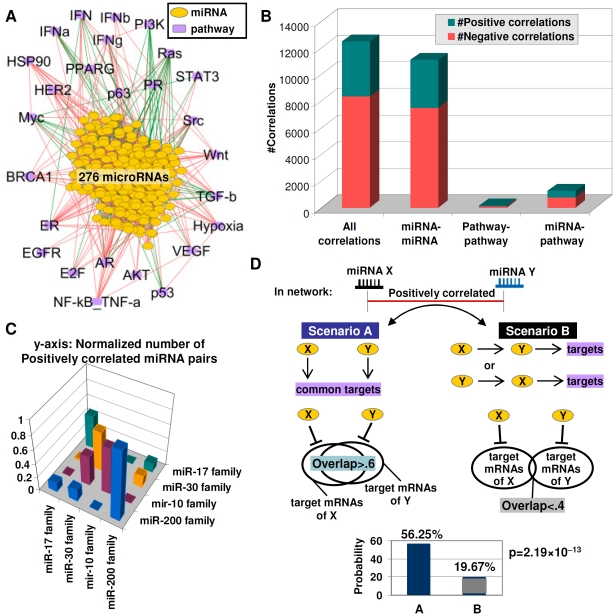
Functional redundancy in the miRNA–pathway network.A) The miRNA–pathway network. Lines represent significant correlations across 276 miRNAs and 26 pathways (red = positive, green = negative). Yellow nodes are miRNAs and purple nodes are pathways. B) Number of positive and negative correlations between different node types (miRNA-miRNA, pathway-pathway, miRNA–pathway). C) Frequency of positively correlated miRNA pairs within and between miRNA families. A taller column indicates a higher frequency of positive miRNA-miRNA correlations. miRNA pairs from the same family show a higher frequency of correlations compared to miRNA pairs between different families. D) Possible scenarios explaining positive correlations between two miRNAs. Scenario A (left) – miRNAs act independently but have common downstream effects (redundancy); Scenario B (right) – one miRNA directly regulates the second miRNA. (bottom) miRNAs with significant overlaps in target mRNAs (overlap ratio >0.6) are more likely to be positively correlated compared to miRNAs with small target mRNA overlaps (overlap ratio <0.4). y-axis: probability of positive correlation. x-axis: miRNA pairs with overlap ratios of >0.6 or <0.4. p-values were computed using chi-square test.